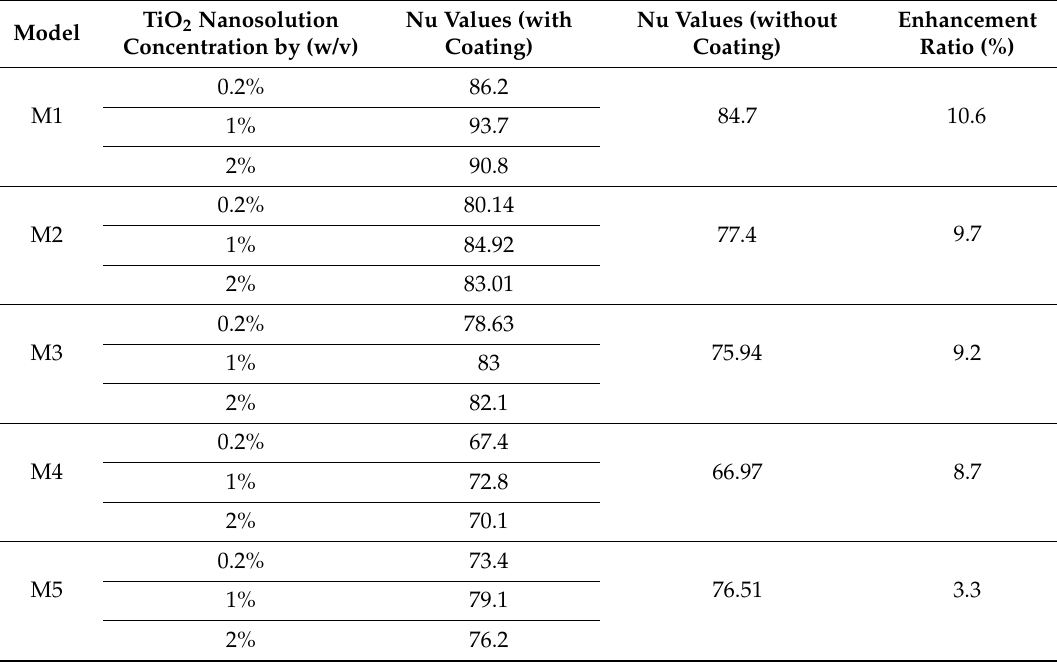
Table 2. Enhancement ratio of TiO 2 -nanocoated surface